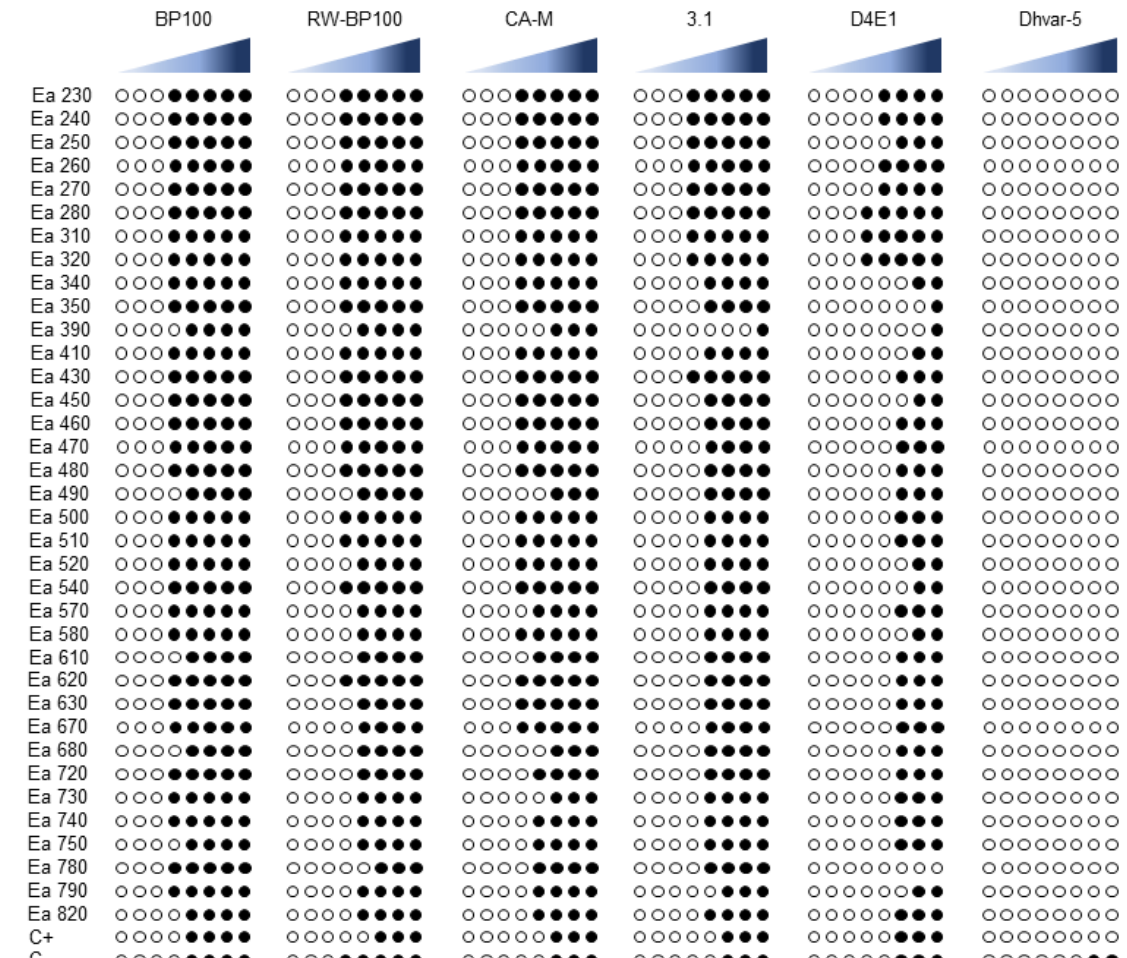
Figure 1. Antibiogram susceptibility to antimicrobial peptides (AMPs) BP100, RW-BP100, CA-M, 3.1, D4E1, and Dhvar-5. Each AMP was tested using eight concentrations, namely, 0.4, 1.6, 6.2, 25, 50, 100, 150, and 200 µ M (increasing concentrations are represented at blue, left to right). : Normal growth; : Inhibited growth. C+: Type strain LMG 2024.